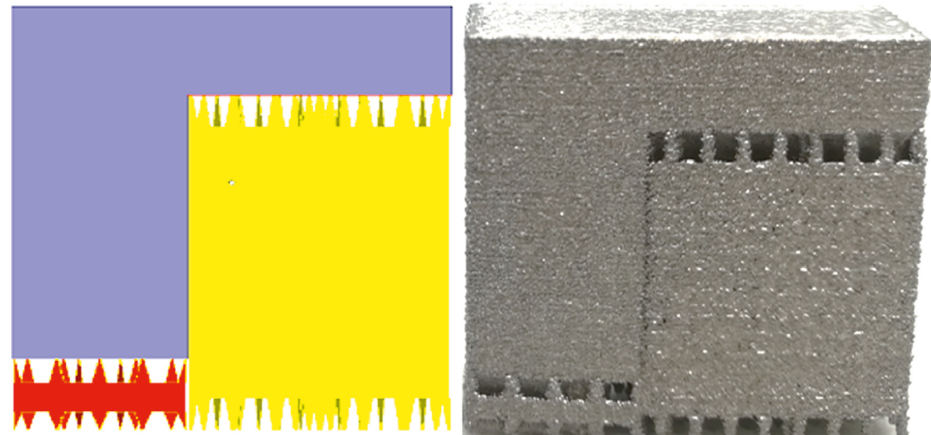
Figure 4: Specimens designed and fabricated.